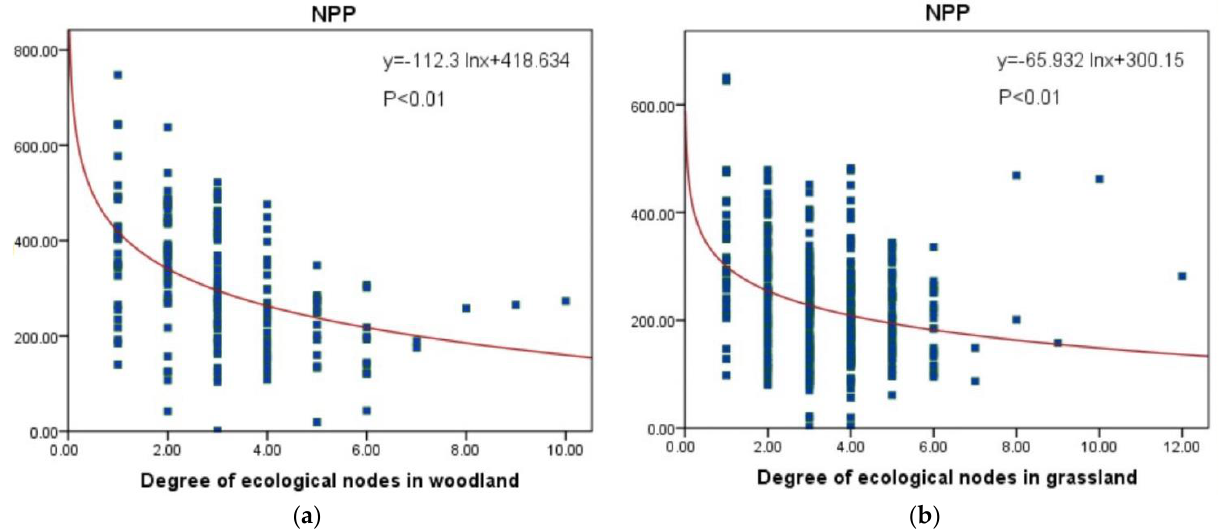
Figure 14. ( a ) Forest NPP – degree correlation distribution and fitting curve; ( b ) grassland NPP – degree correlation distribution and fitting curve.